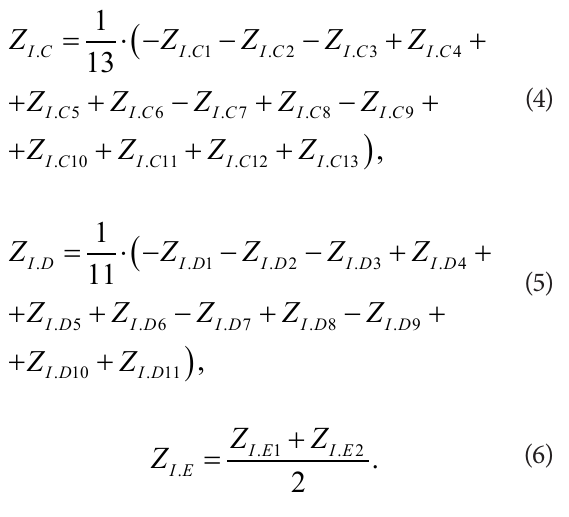
Table 13. Standardized results of the tool